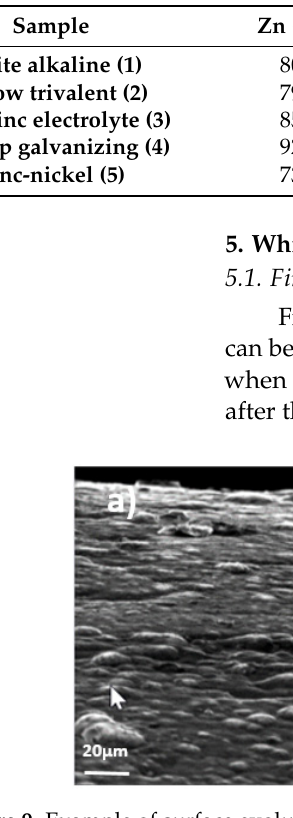
Figure 9. Example of surface evolution in white alkaline electrolyte (sample 1) under compressive stresses (F); ( a ) month 1, ( b ) month 3.